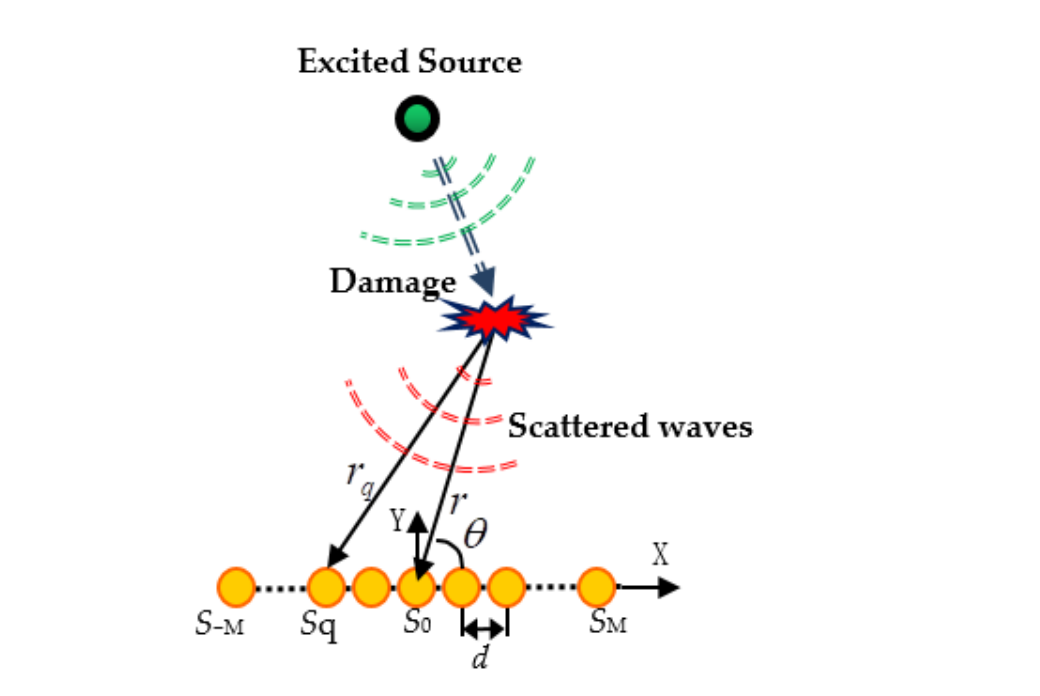
Figure 1. Damage scattered signal model.